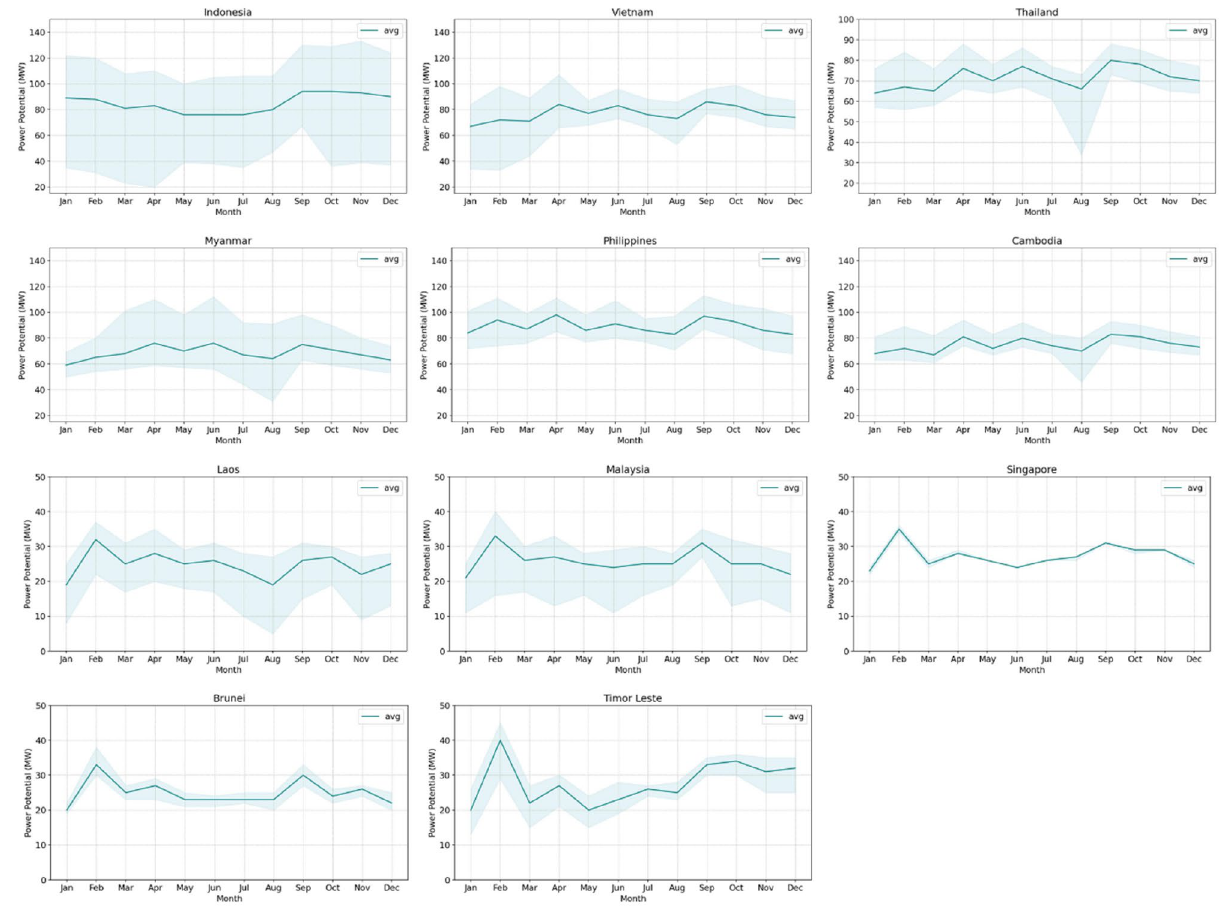
Figure 9. Time series analysis of the sensitivity of potential solar photovoltaic (PV) energy in Southeast Asian power was relatively low. In contrast, Singapore and Timor Leste had the smallest value ranges. These results indicate that the monthly power potential in Singapore and Timor Leste have relatively high sensitivity. The